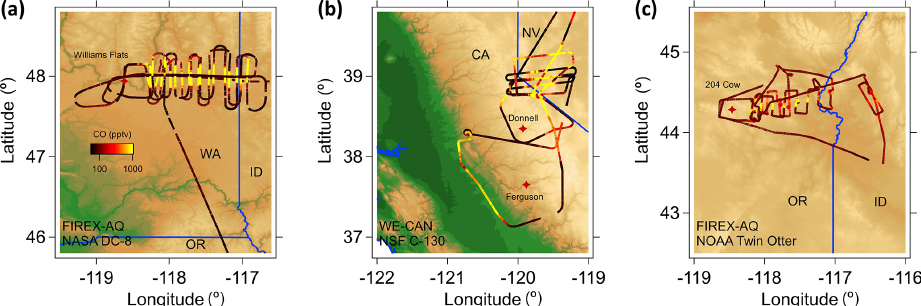
Figure 3. Examples of flight tracks for measurements made near and downwind of fires in the western USA for (a) the NASA DC-8 on 7 August 2019 in FIREX-AQ (MC-LWCC); (b) the NSF C-130 on 6 August 2018 in WE-CAN (CSU PILS-LWCC); and (c) the NOAA Twin Otter on 24 August 2019 in FIREX-AQ (NOAA PILS-LWCC). Each flight is color-coded by the CO mixing ratio. Fires are labeled with red